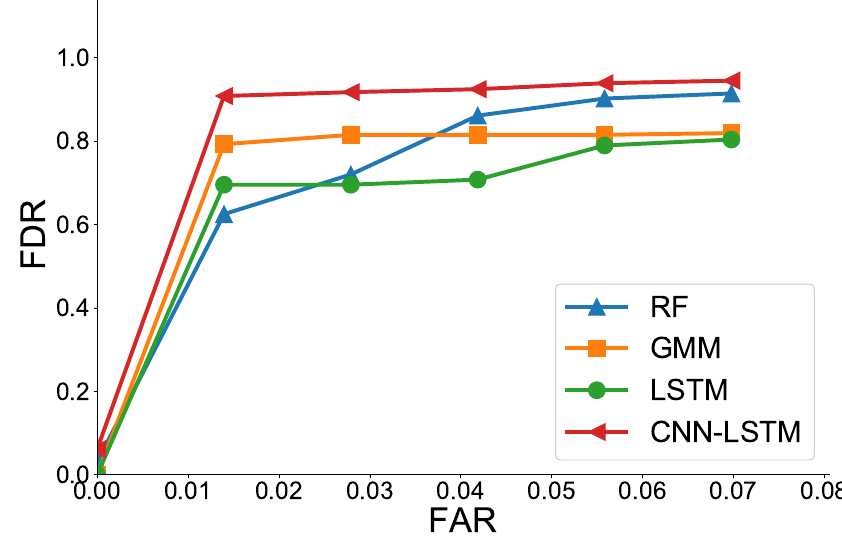
Figure 10. ROC curves of various ML models at low